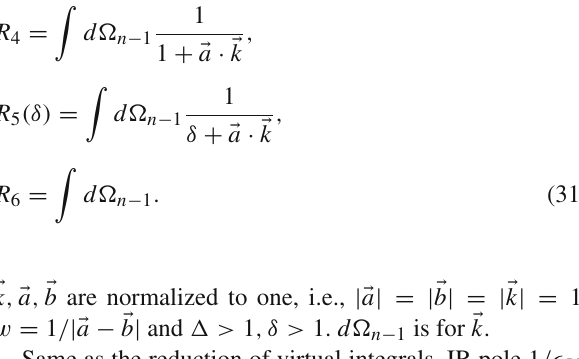
hand side of the cut are outgoing. The thick line is for heavy quark. The thin real line is for massless parton. Off-shell external momenta are represented by double